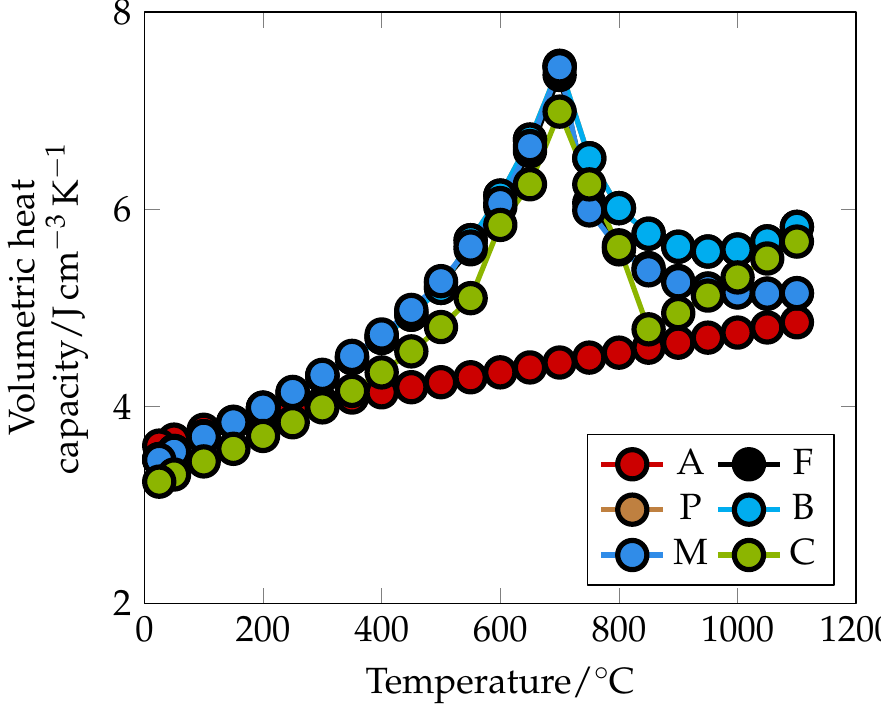
. ent phases of X30Cr13 calculated by JMatPro R . (cid:13) (cid:13)